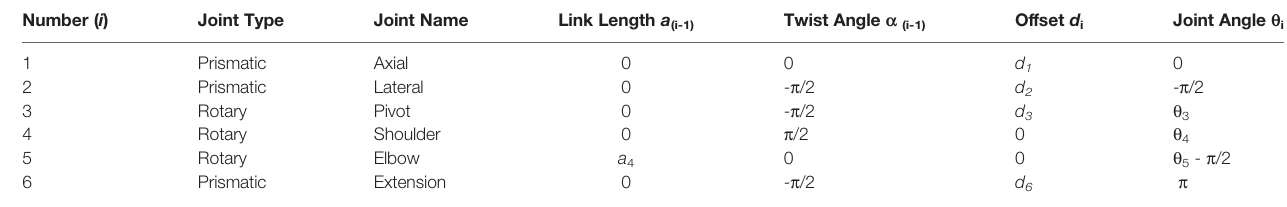
TABLE 1 | Joint de fi nitions and D-H